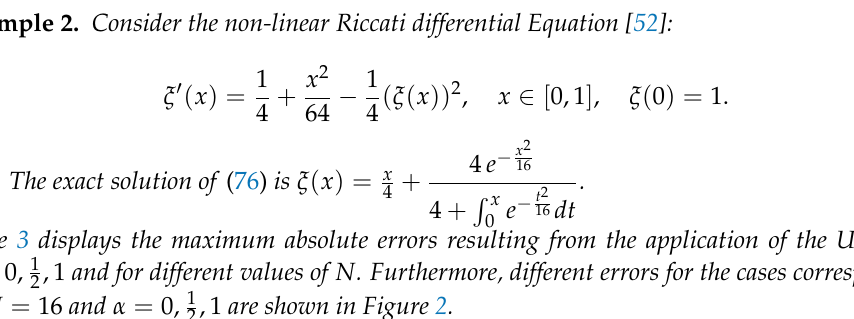
Figure 1. Different errors of Example 1 for different values of α .